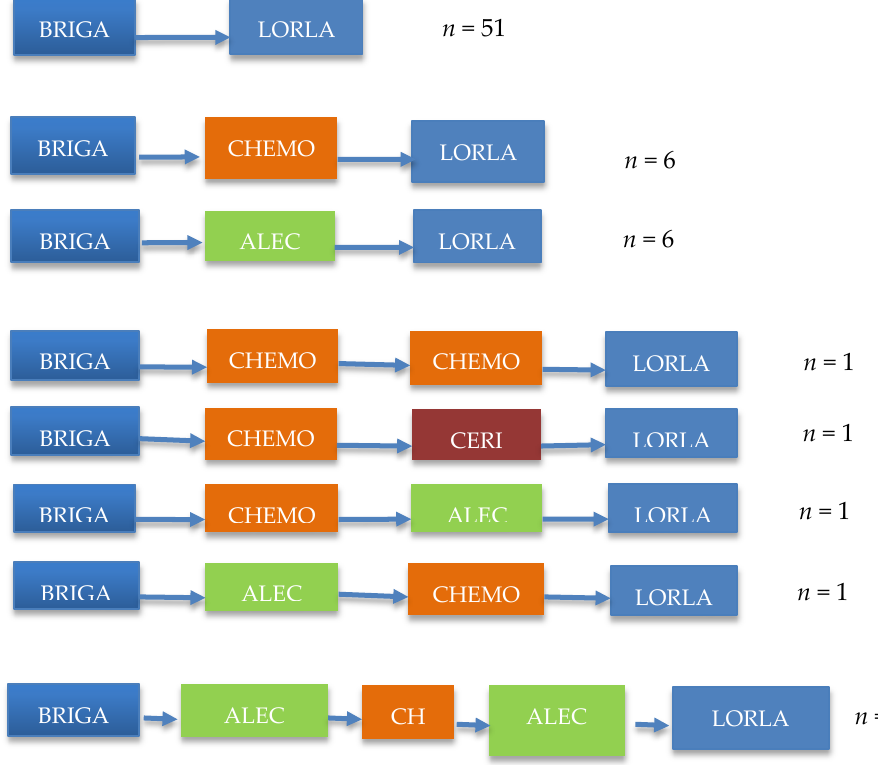
Figure 3. Therapeutic sequences after brigatinib.